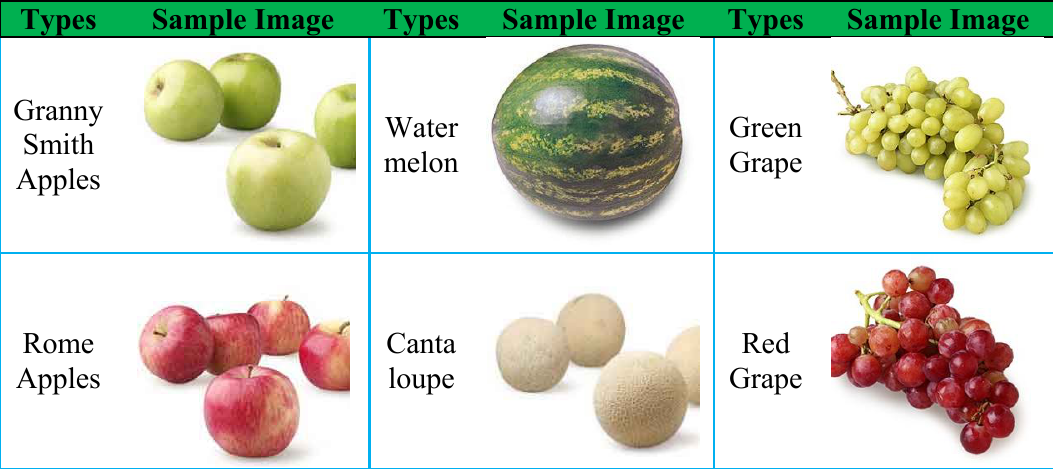
Table 1. Samples of Fruit dataset of 18 different